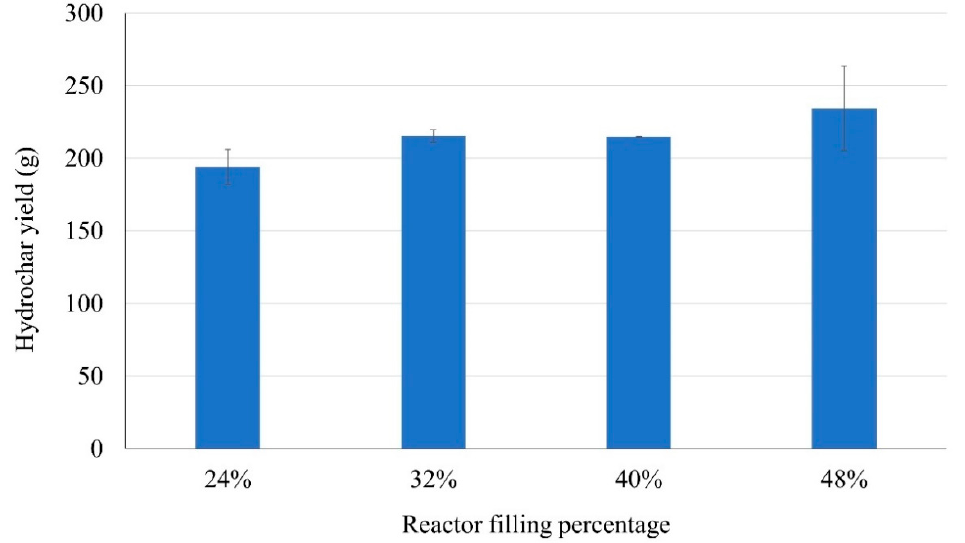
Figure 3. Hydrochar yield production for different filling percentages of the HTC reactor.